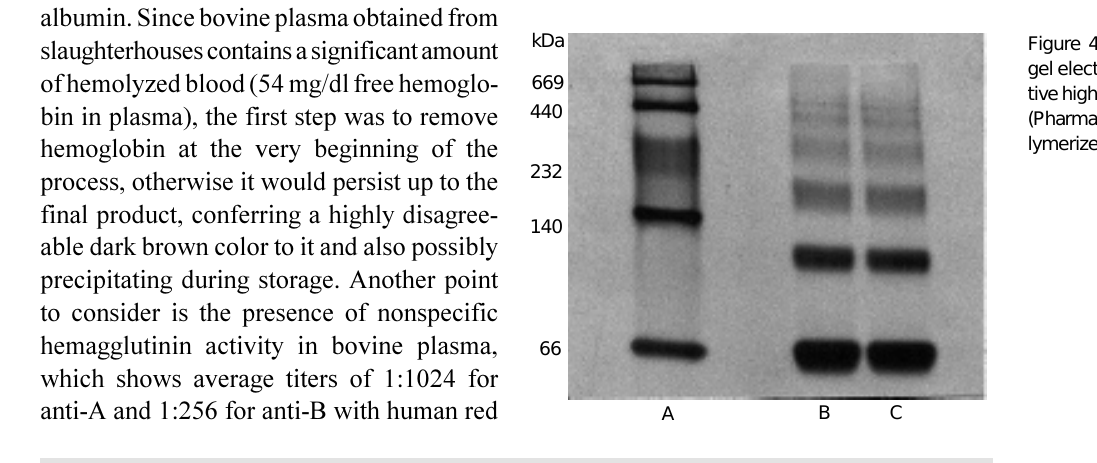
Table 2. Treatment of bovine albumin with different concentrations of glutaraldehyde/formaldehyde. Glut/form con- Monomer (%) Dimer (%) Trimer (%) Polymer (%) Color intensity of albumin centration (%) (absorbance at 403 nm) 0.00/0.00